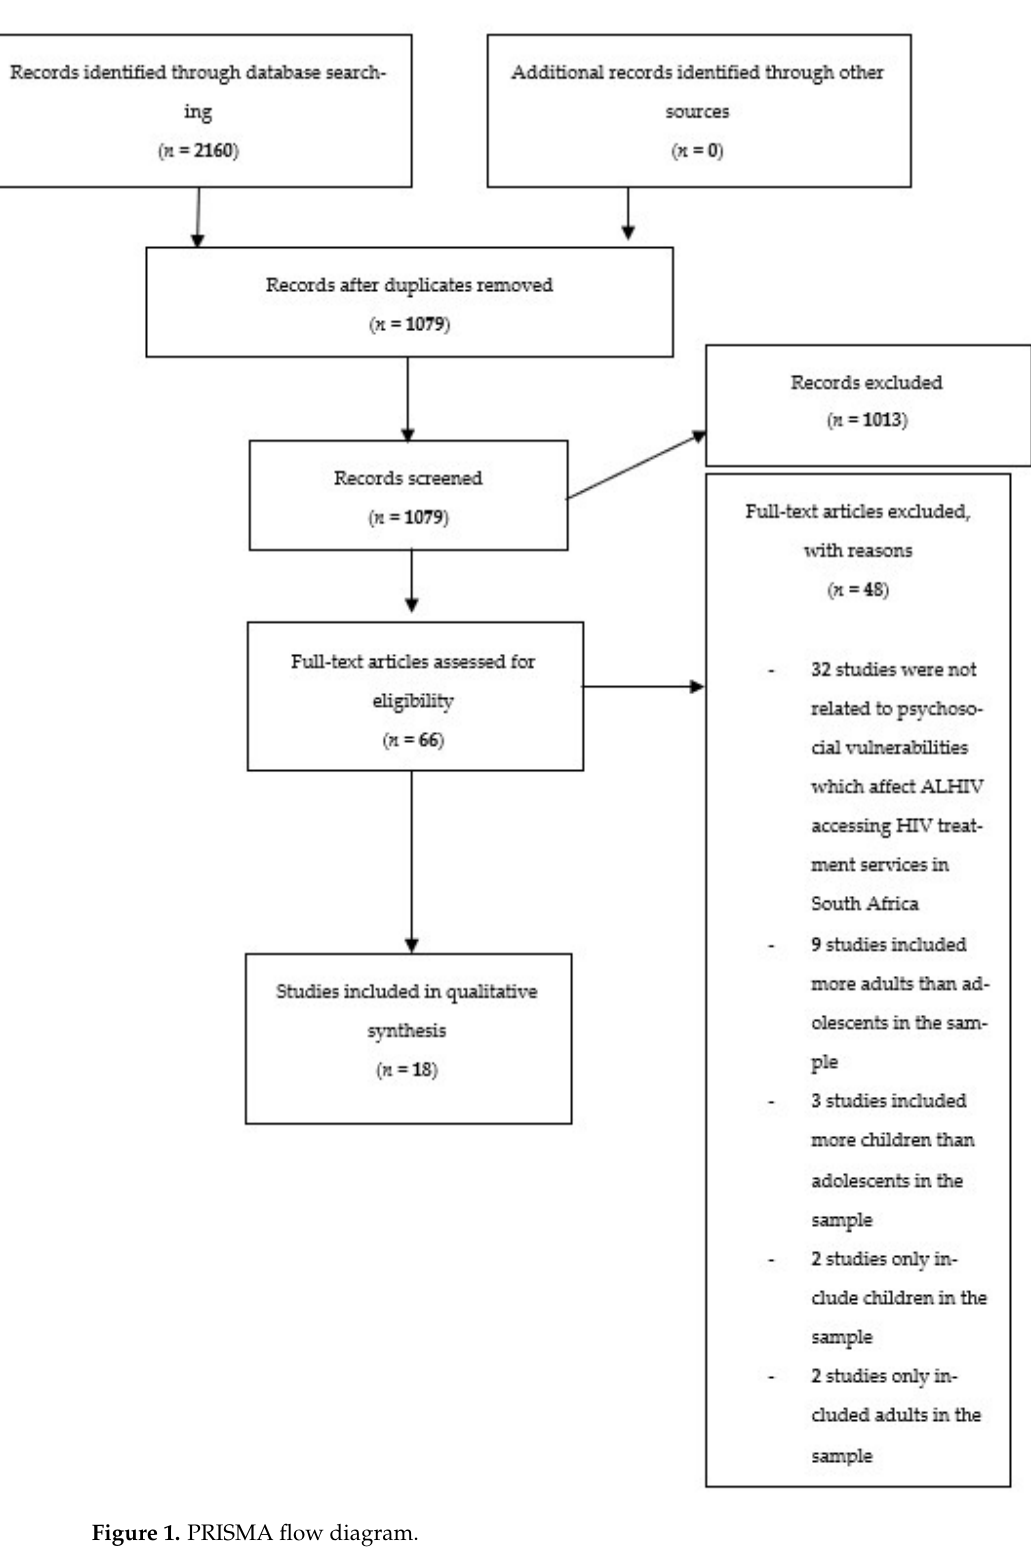
Figure 1. PRISMA flow diagram.